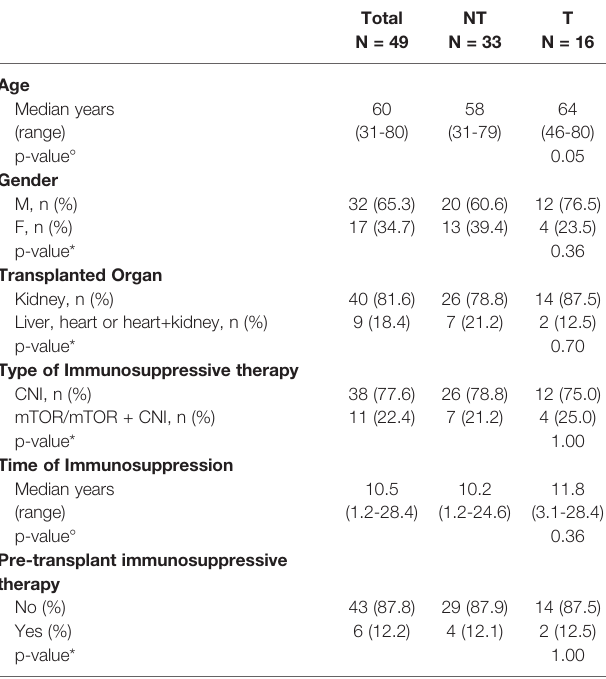
TABLE 1 | Baseline demographic and clinical characteristics of the 49 SOT